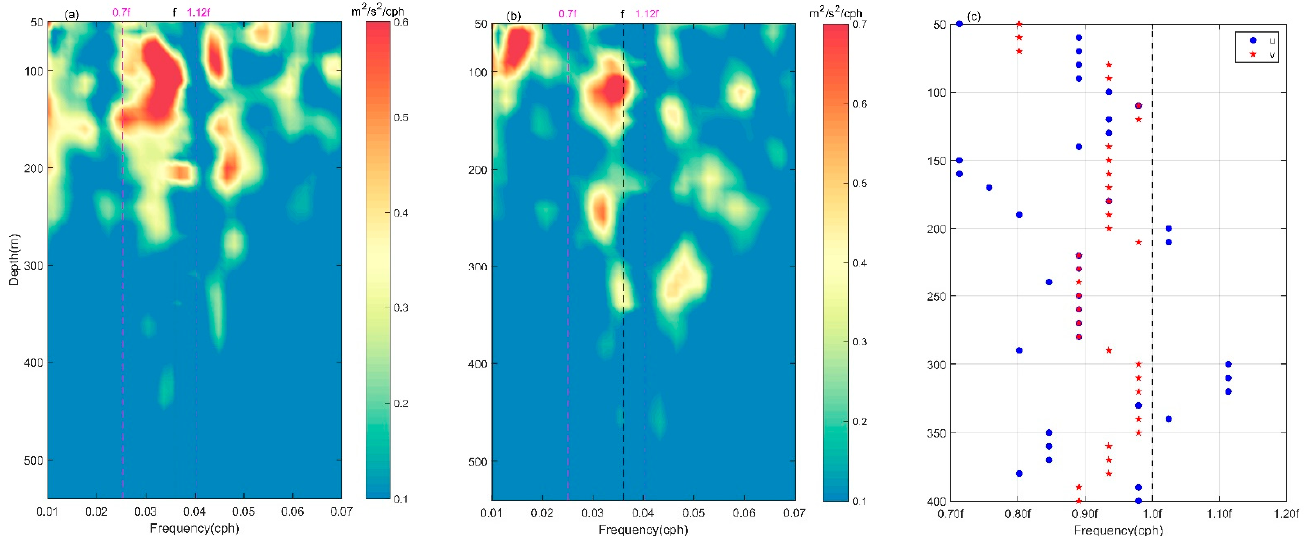
Figure 11. ( a ) Depth–frequency map of the power spectral density of zonal residual currents at the mooring. Vertical dashed lines indicate a frequency of 0.70 f , local inertial frequency f, and frequency of 1.12 f . ( b ) Same as ( a ), but for meridional residual currents. ( c ) Variation in the near-inertial spectral peak frequency with depth. The blue dots and red stars represent the results of the zonal and meridional residual currents, and the vertical dashed line denotes the frequency of 1.00 f .